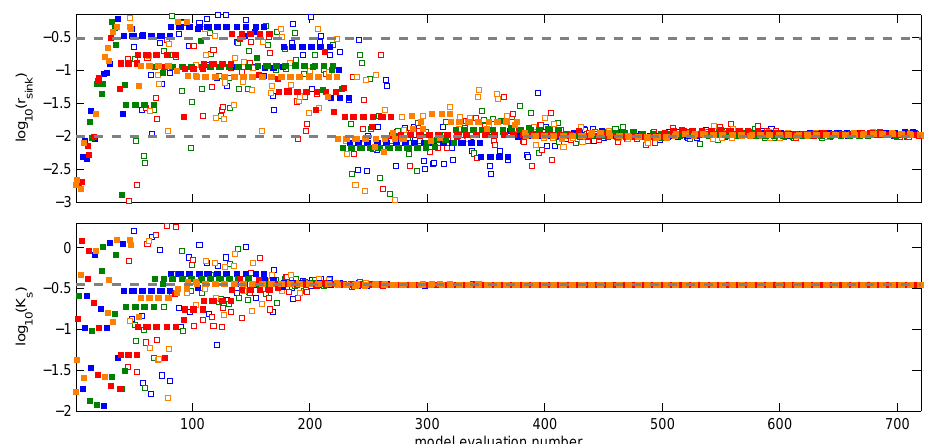
Fig. 6. SODA (idealized data set): evolution of the parameters. Dashed lines represent value of r sink ( low ) and r sink ( high ) (upper plot) and K s (lower plot). Markov chains are color-coded; open symbols are samples that have been rejected by the Metropolis scheme, while solid colors have been accepted. Note that the vertical axes are logarithmic.